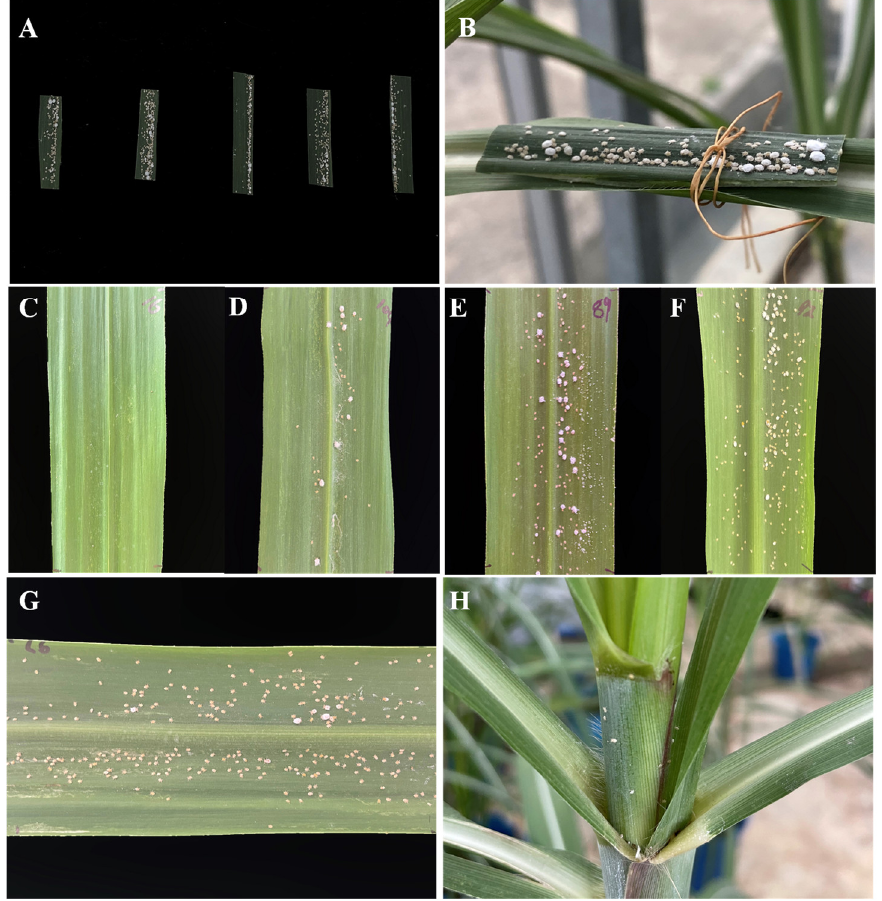
Figure 2. Aphid resistance tests. ( A ) Preparation of the leaf sections with equally distributed sugarcane woolly aphids. From left to right, PPA−16, 89, 92, 97 and PPA−104 plants were inoculated with leaf sections. ( B ) Leaf sections with aphids were gently tied to the positive fourth leaves of sugarcane lines. Aphid status was recorded daily, and conditions after five days are shown in ( C ) PPA−16; ( D ) PPA−104; ( E ) 89; ( F ) 92; ( G , H ) 97.